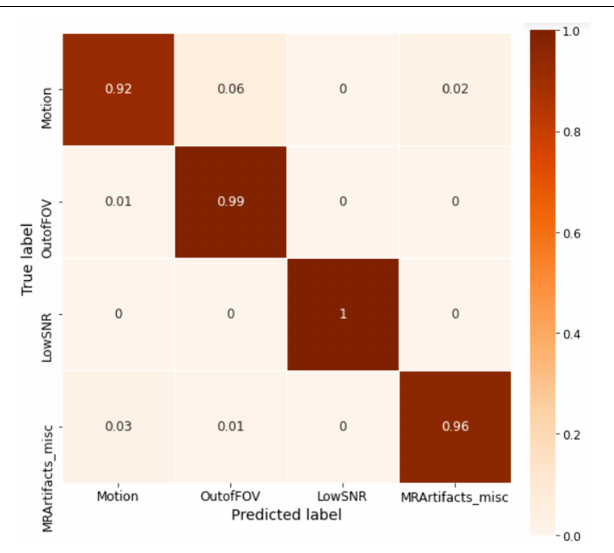
FIGURE 11 | The whole volume-level confusion matrix of the test set of HBN. Voting process further decreased the misclassifications and turned the matrix more